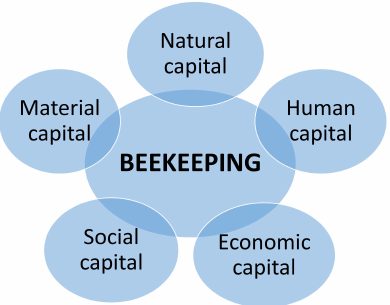
Figure 2. Types of capital needed for beekeeping. Source: Own